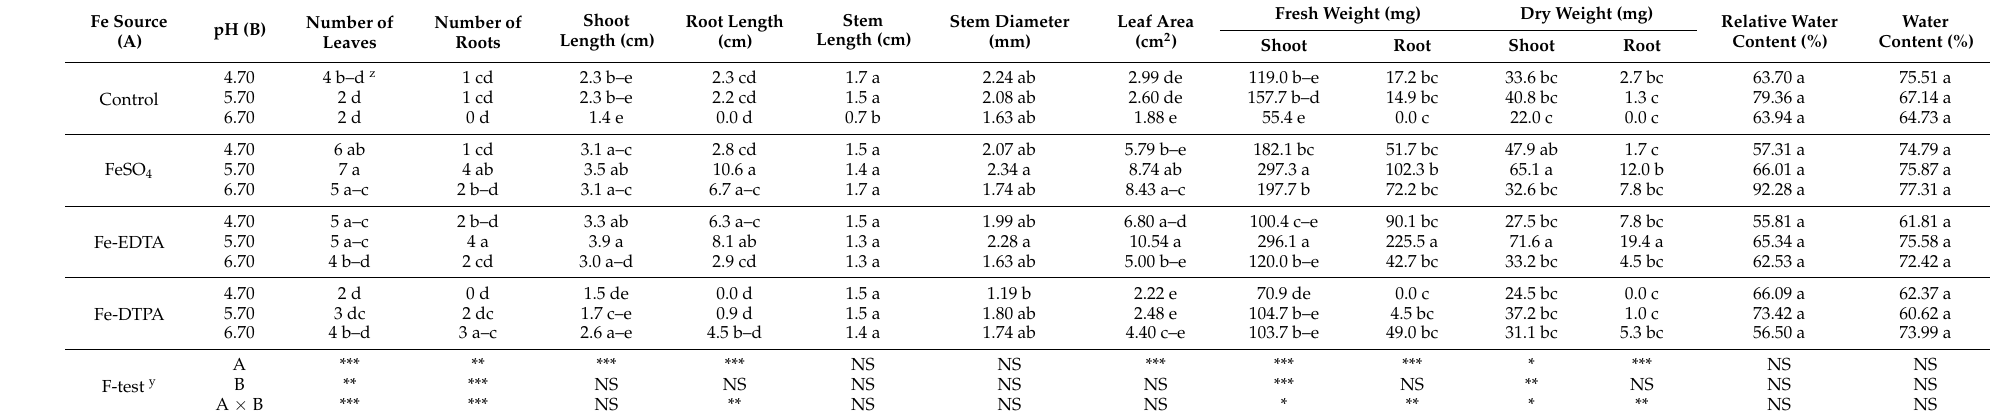
Figure 1. Photographs showing morphology of S. commixta as affected by the Fe source and medium pH after 6 weeks of culture: ( A ), a top view of the plantlets still in the medium; and ( B ), representative individual plantlets. The bars in each photograph indicate 1 cm. Table 1. The growth parameters of S. commixta after 6 weeks of